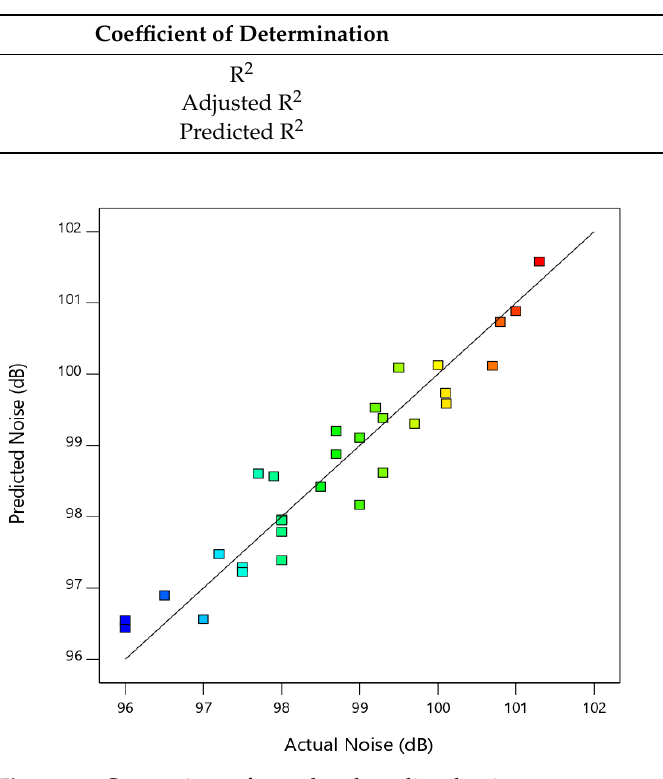
Figure 10. Comparison of actual and predicted noise.